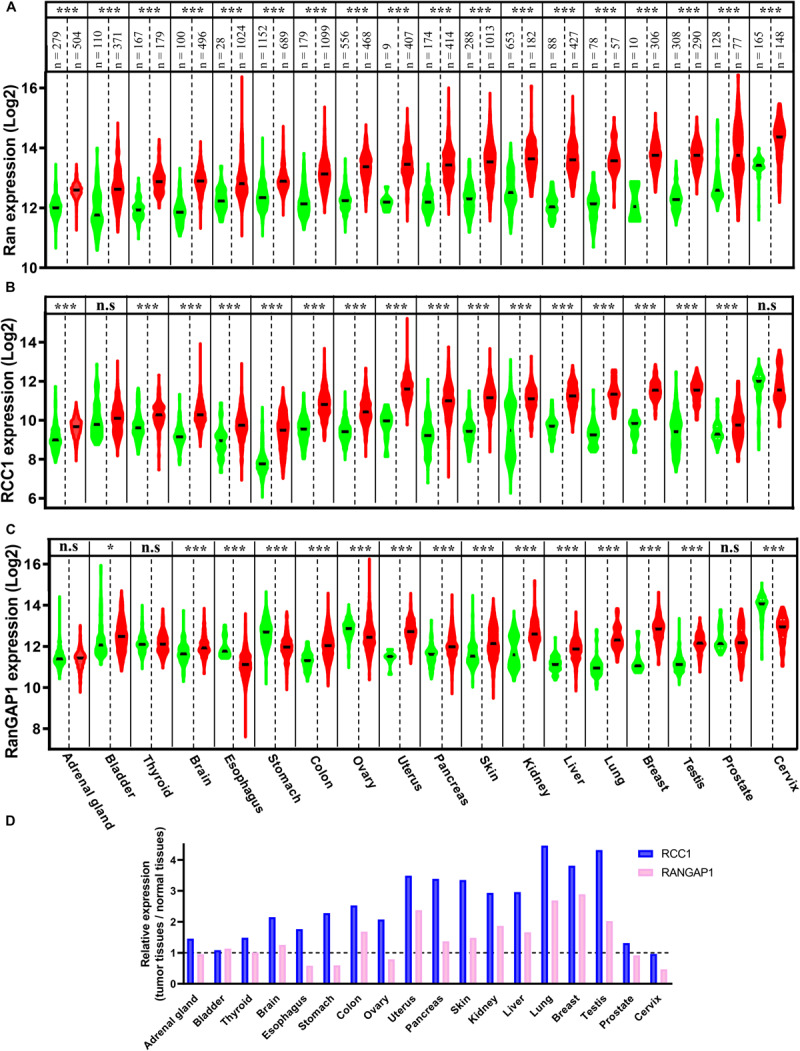
The expression of Ran, Regulator of Chromosome Condensation 1 (RCC1), and RanGAP1 in normal and tumor tissues. The expression of Ran (A), RCC1 (B), and RanGAP1 (C) in normal (green) and tumor tissues (red) was extracted from the Xenabrowser web site. *p < 0.05, ***p < 0.001 (Student’s t-test). (D) The expression of RCC1 (blue) and RanGAP1 (pink) in cancer tissues was expressed as the fold change over normal tissues.